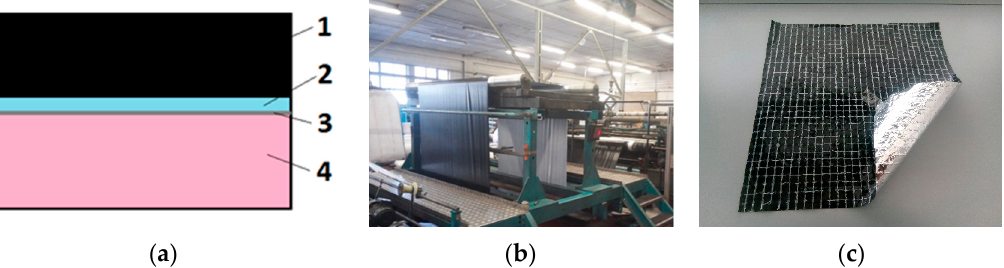
Figure 1. Solar absorber development: ( a ) scheme of the developed absorber: 1—polyethylene absorbent layer with 5% pigment, thickness (th.). 20 µ m; 2—adhesive polyethylene bridge, th. 2 µ m; 3—vapor-coated aluminum, th. 0.04 µ m; 4—structural layer of MPET, th. 23 µ m; ( b ) industrial roll-to-roll production line; ( c ) sample of a prototype with biaxially oriented polypropylene fabric.